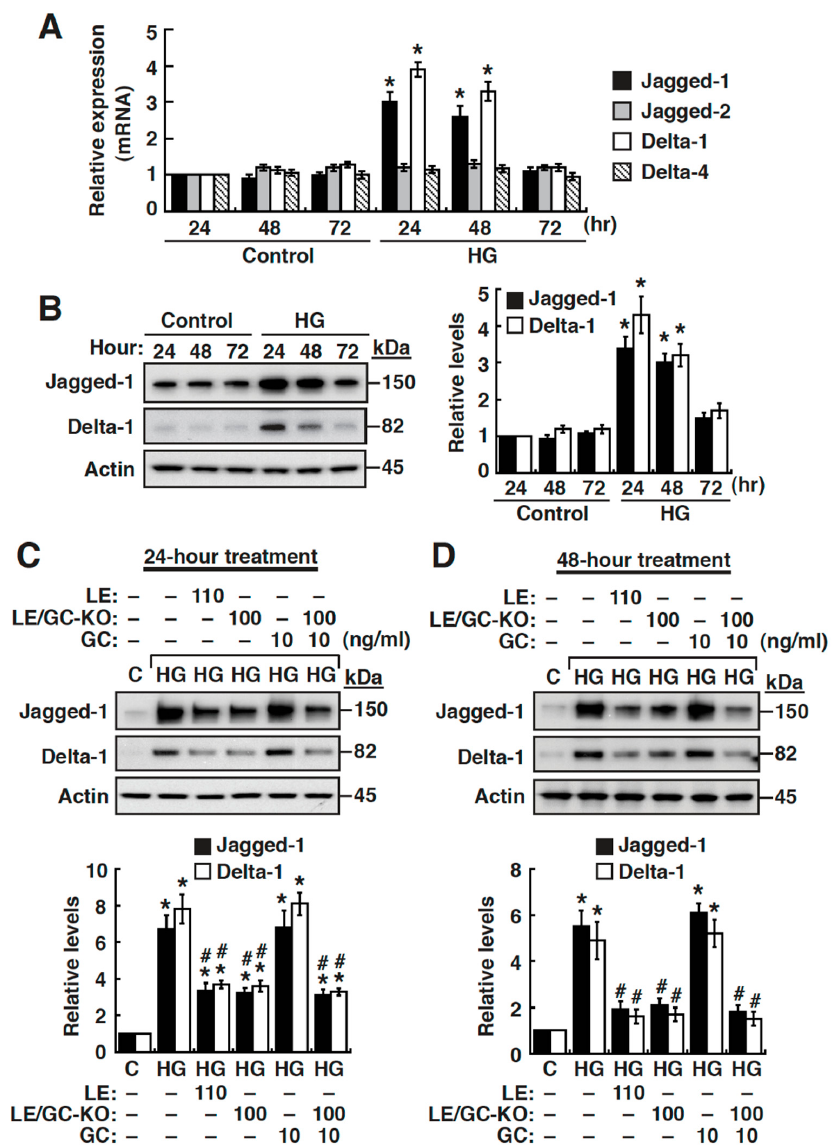
Figure 7. The expression of Jagged-1 and Delta-like 1 is upregulated in HG-cultured NRK-52E cells, which can be attenuated by LE or LE / GC-KO. ( A ) Quantitative RT-PCR analysis of various Notch ligands (including Jagged-1 , Jagged-2 , Delta-like 1 and Delta-like 4 ) in normal or HG-cultured NRK-52E cells. * p < 0.05 versus normal controls for the indicated time points, n = 3. ( B ) Western blot analysis of Jagged-1 and Delta-like 1 expression in NRK-52E cells cultured in normal or HG conditions. * p < 0.05 versus normal controls for the indicated time points, n = 3. ( C , D ) E ff ect of LE, LE / GC-KO or GC on the expression of Jagged-1 and Delta-like 1 in HG-cultured NRK-52E cells. At 24 h or 48 h after treatment, cells were harvested for Western blotting. * p < 0.05 versus the normal control, # p < 0.05 versus untreated HG-cultured cells ( n =